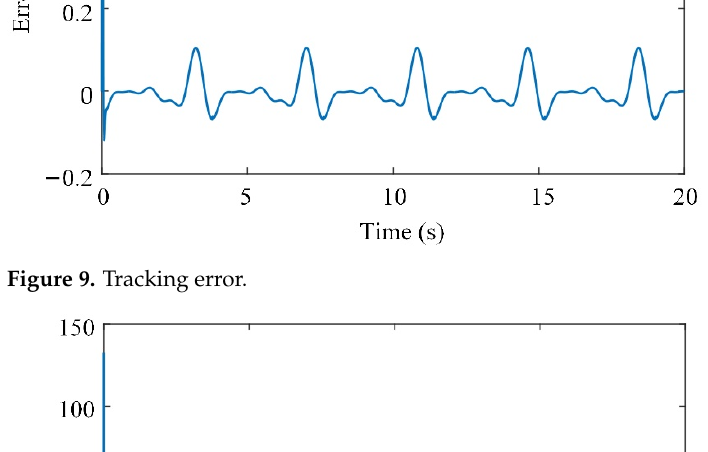
Figure 8. Desired trajectory.